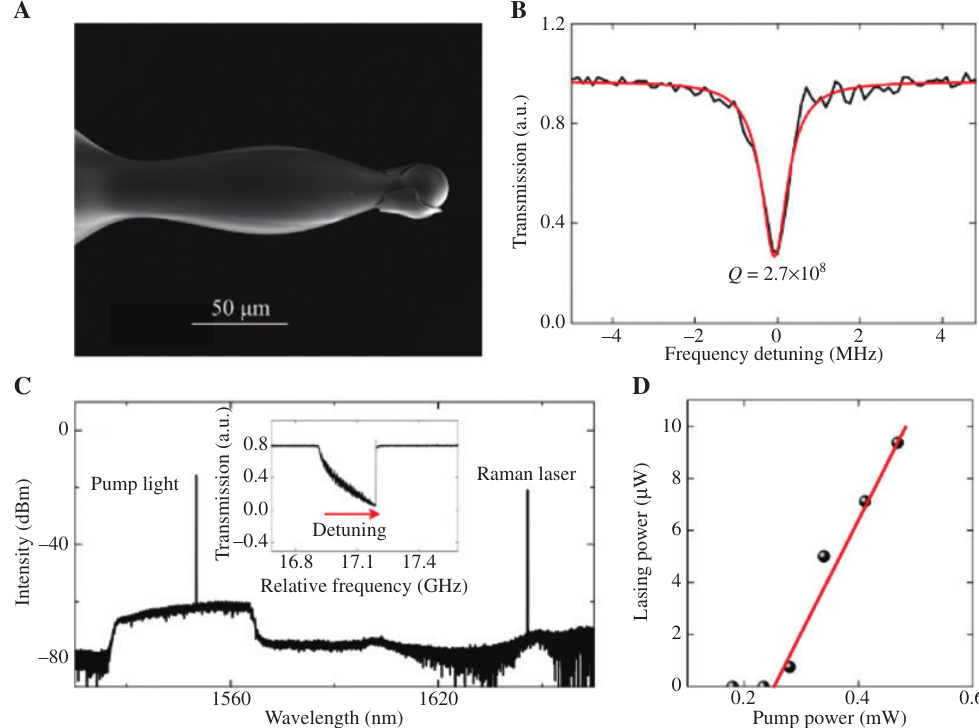
Figure 8: Device performance of the hybrid microbottle resonator with an equatorial diameter of about 47 μ m. (A) SEM image of the hybrid microbottle resonator. (B) Measured transmission spectrum of a specific mode. The red line denotes Lorenz fitting. (C) Raman lasing spectrum when the pump power is 0.51 mW. The inset represents the asymmetric transmission spectrum of the specific mode. (D) Raman lasing power as a function of the pump power. The red line denotes a linear relation between the lasing power and the pump